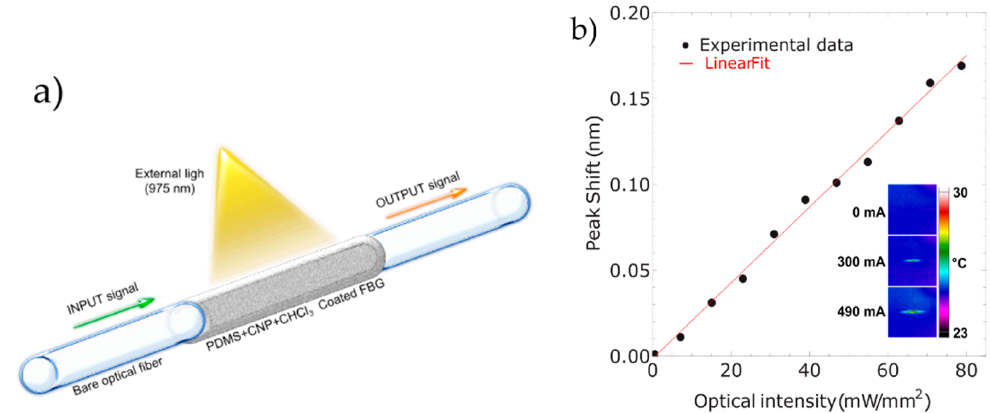
Figure 8. ( a ) schematic of FBG coated with a thin layer of the PDMS+CNP+CHCl 3 composite irradiated with a focused IR laser beam; ( b ) FBG peak shift generated by light irradiation of the composite. The inset shows images obtained with the thermographic camera demonstrating localized heating on the irradiated section.